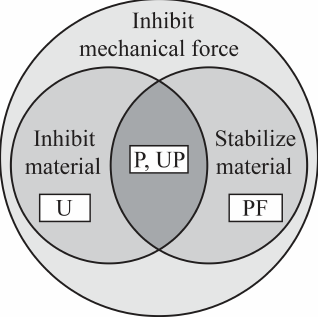
Figure 22. Devices in the P and UP fold states commonly perform the functions: inhibiting material, inhibiting mechanical force, and stabilize material. The Venn diagram shows the overlap of the fold states between these three